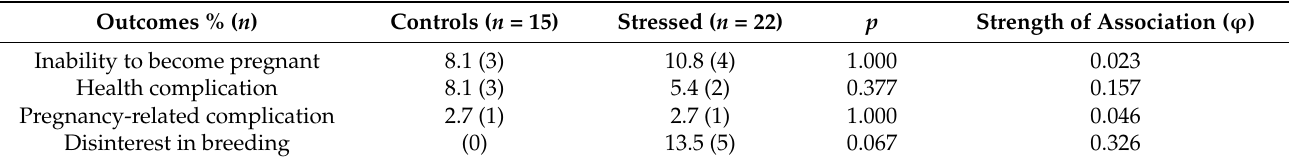
Table 1. Results of the Fisher’s exact test for association between treatment (SIS and controls) and adverse health outcomes. Adverse health outcomes were assessed in noticeably unhealthy dams from both control and stress groups.